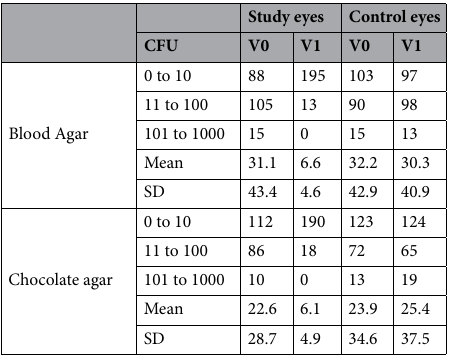
Table 2. Colony-forming units in the study and control group. CFU colony-forming units, V0 baseline visit, V1 visit the day of intravitreal injection, SD standard deviation.